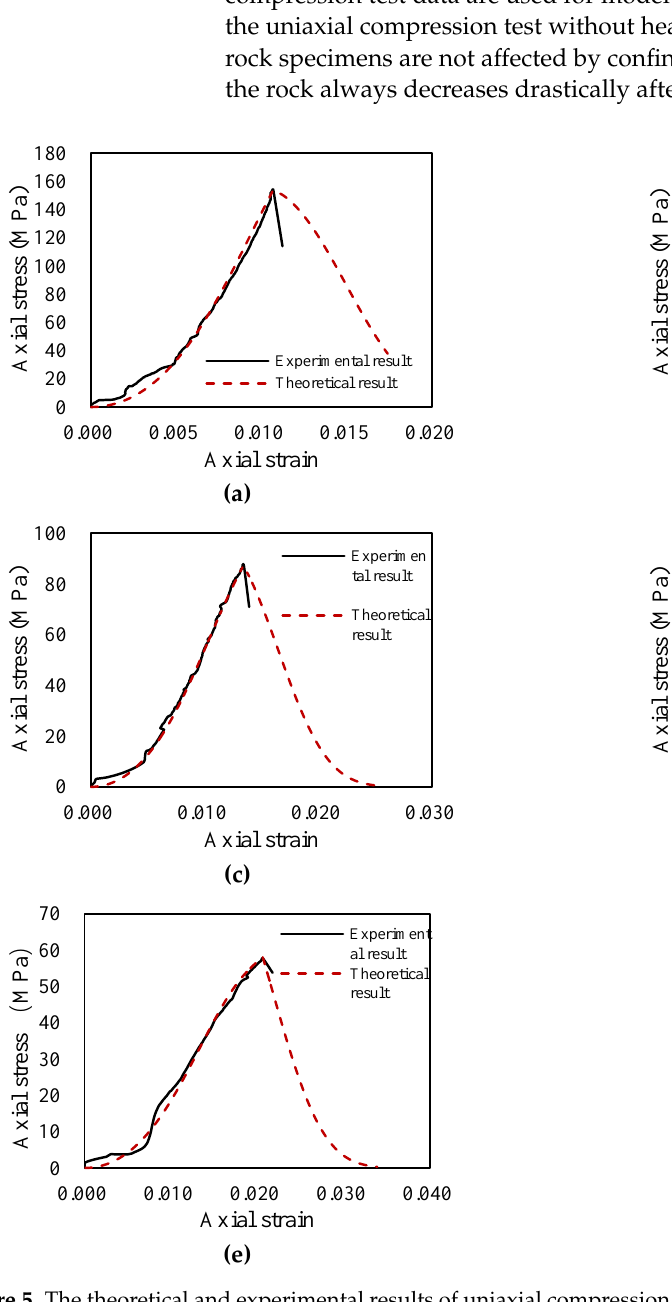
Figure 5. The theoretical and experimental results of uniaxial compression tests of granite subjected to ( a ) 200 °C, ( b ) 400 °C, ( c ) 600 °C, ( d ) 800 °C, and ( e ) 1000 °C .